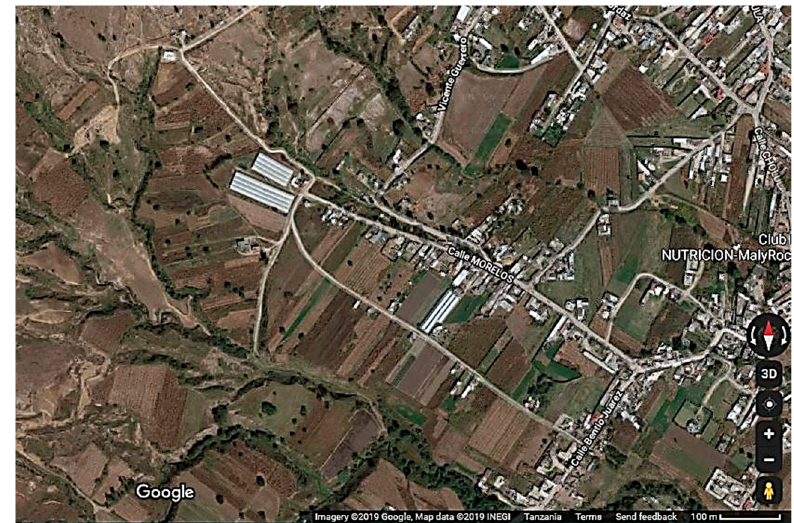
Figure 6. Built Ejido land in Santa Clara Ocoyucan. Source: Google Maps (accessed 23 July 2019). Land use: Rural–farming land; Tenure System: Communal land/ ejido ; Stakeholders: Ejidatarios , Rural population, Local authorities.